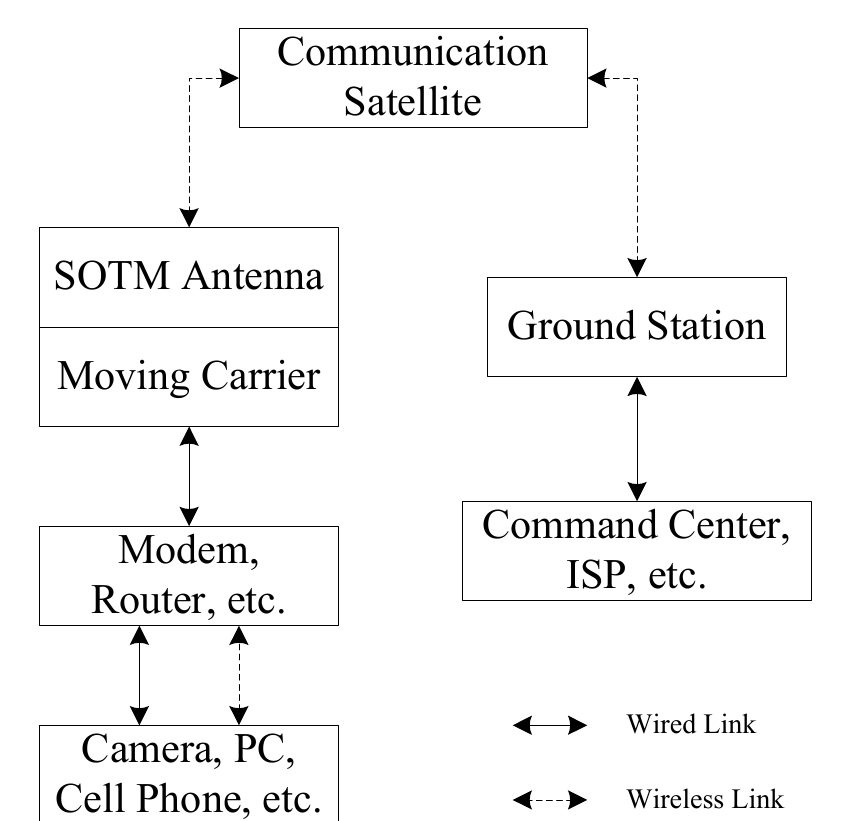
Figure 1. Overview of SOTM satellite communication link.